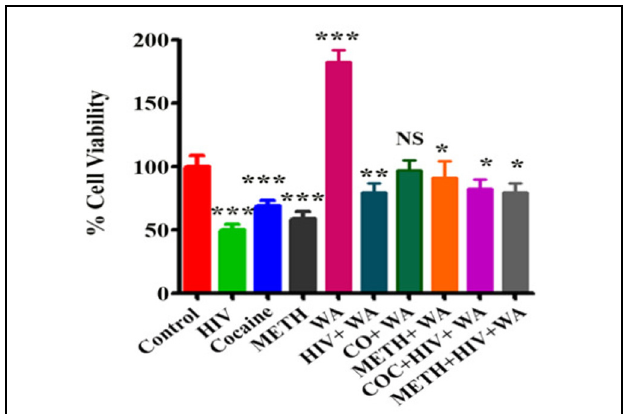
FIGURE 4 | Effect of Withanolide A on viability of SK-N-MC cells treated with HIV-1Ba-L (clade B), Cocaine and Methamphetamine (METH): SK-N-MC cells were infected with HIV in the presence of Cocaine/METH. The MTT assay is showing that Withanolide A reverse the neurotoxic effects on cell viability induced by HIV, Cocaine, METH and combined treatment. Withanolide A alone showed significant increase in cell viability. The values were expressed as percentage of cell viability compared to control cells and are the mean ± SD of four experiments. ∗∗∗ , ∗∗ , ∗ indicates a statistically significant difference ( p ,0.0001), ( p ,0.0006), and ( p ,0.0185), respectively, compared to controls. WA, Withanolide A; CO, COC, Cocaine; METH, Methamphetamine. [Reproduced with permission from Kurapati et al.